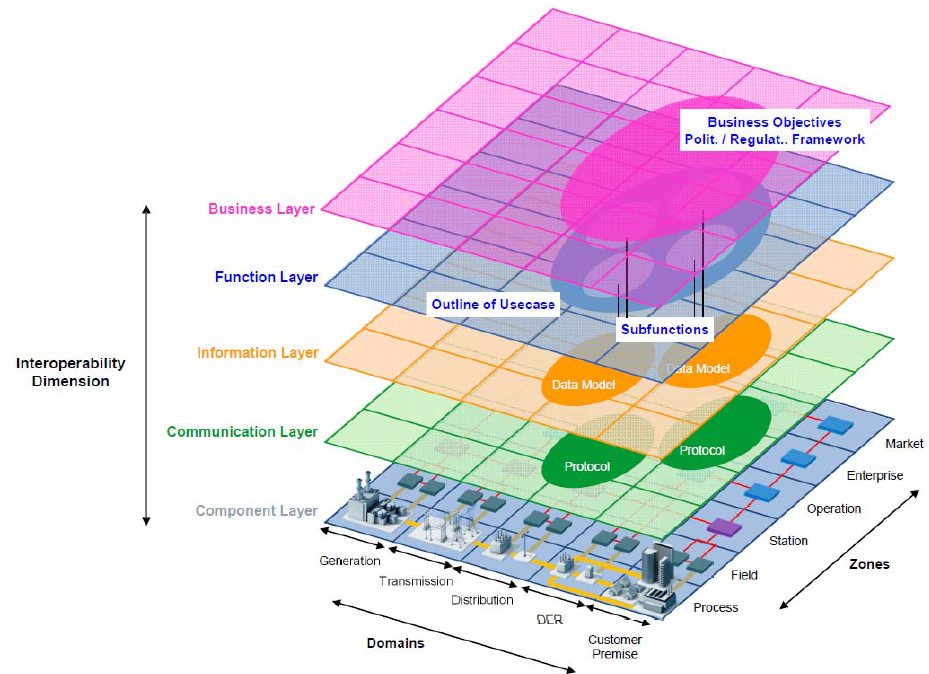
Figure 4. CEN/CENELEC/ETSI SGAM